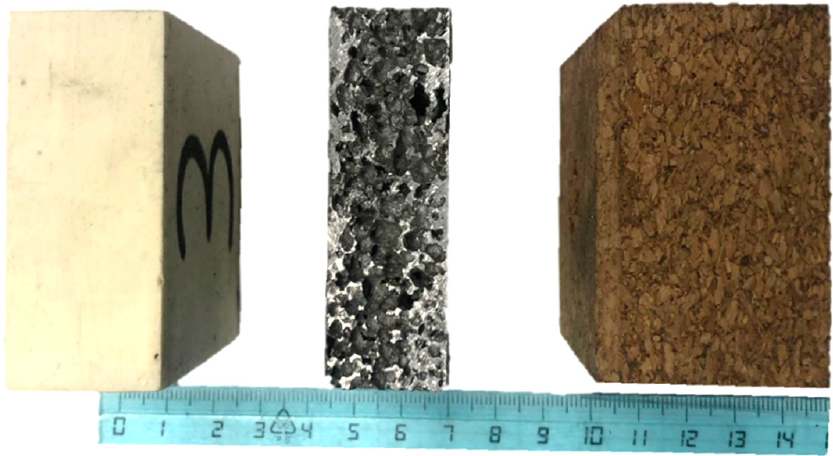
Figure 1. Investigated materials: PUF ( left ), AF ( middle ) and AC ( right